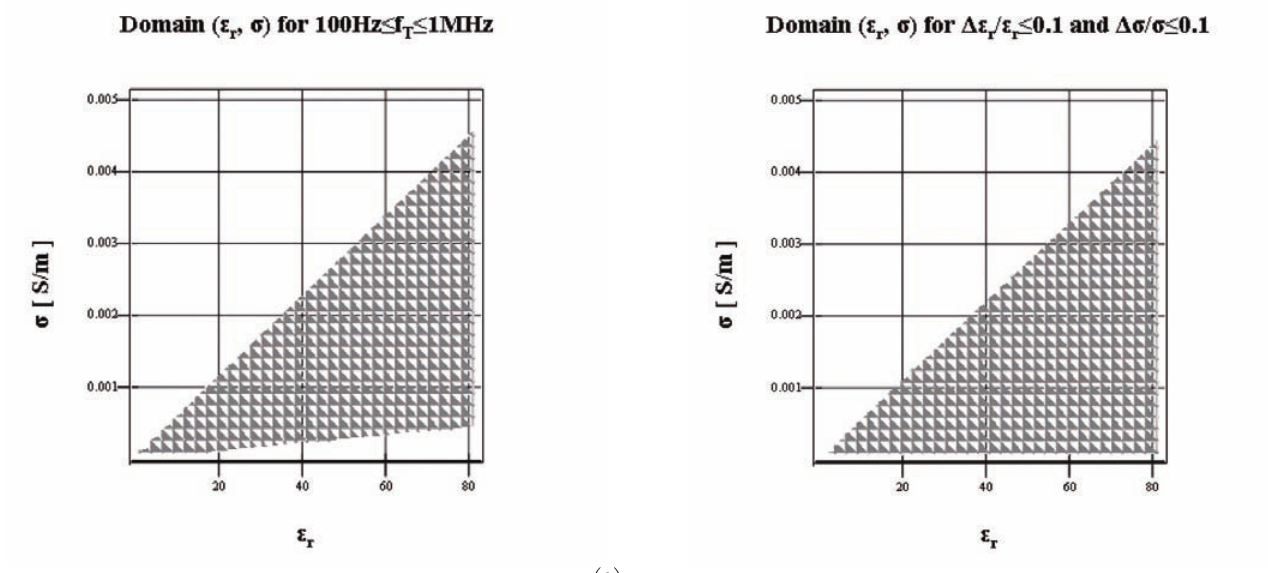
Figure 11. With reference to a quadrupole probe in galvanic contact, working in a fixed band B = 100 kHz, plots for the domains ( v , f electrical conductivity v and the dielectric permittivity f such that: (a) the transfer impedance is characterized by a modulus with a cut-off frequency r f = f ( v , f ) = v /(2 rf ( f +1)) in the interval f [100 kHz, 1 MHz]; (b) both the inaccuracies Dv / v ( v , f T T r r T ∈ 0 v , and Df r / f r ( v , f r ) of the permittivity f r are below a prefixed limit of 10% [ D | Z |/| Z |= DU Z / U Z = 10 −3 ]. See also Tables 1 and